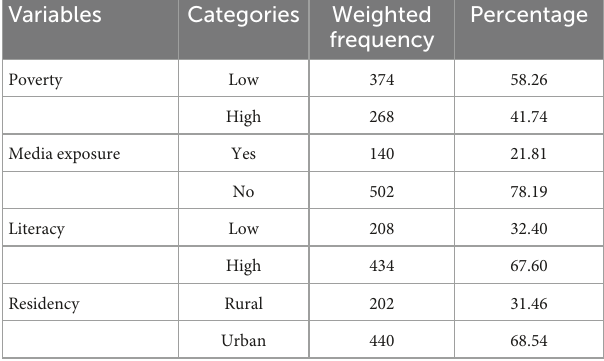
TABLE 2 Community level characteristics of the study